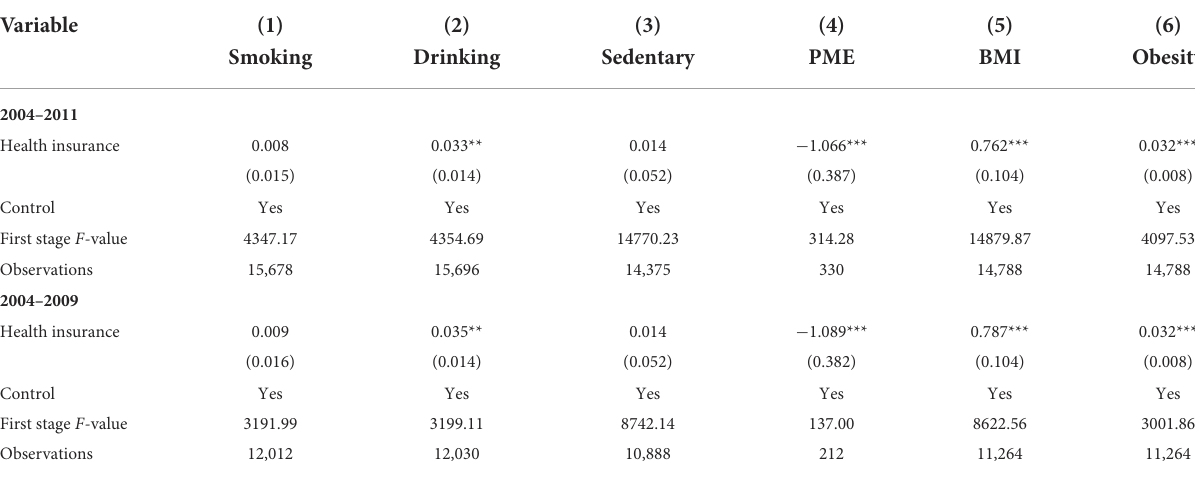
TABLE 9 Robustness check